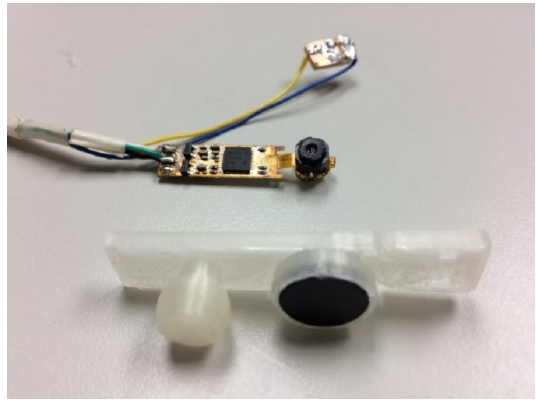
Figure 4. Camera module housing.